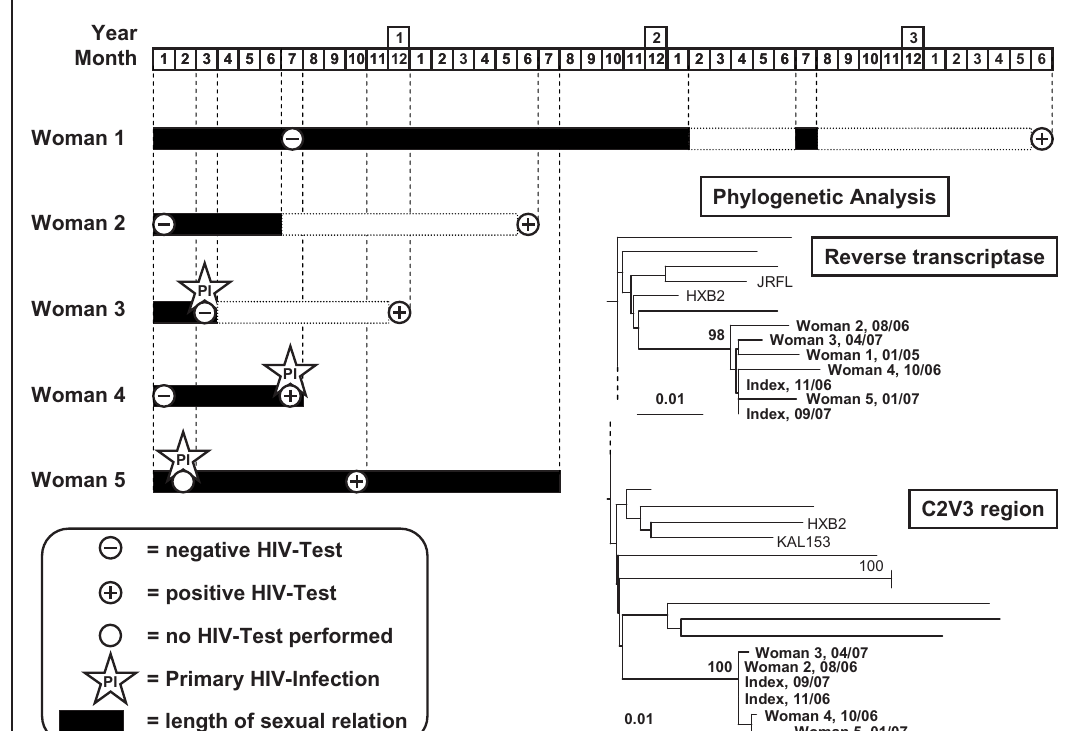
Time course of the five sexual relations of the index patient and phylogenetic re- lationship of the HIV-